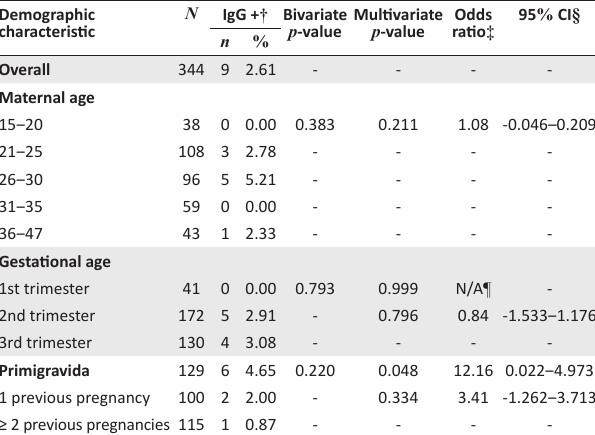
TABLE 1: Association of demographic characteristics with seroprevalence of Toxoplasma gondii among urban pregnant women ( N = 344) attending public antenatal care in Windhoek, Namibia, 2016. Demographic